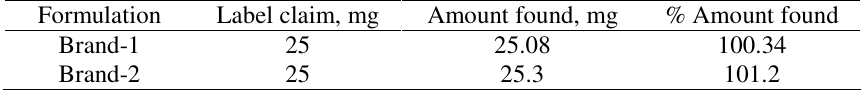
Table 2. Assay of